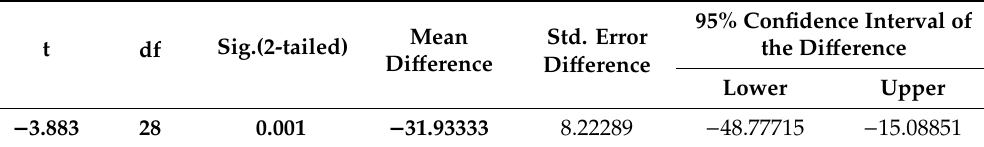
Table 11. T-test for E ffi